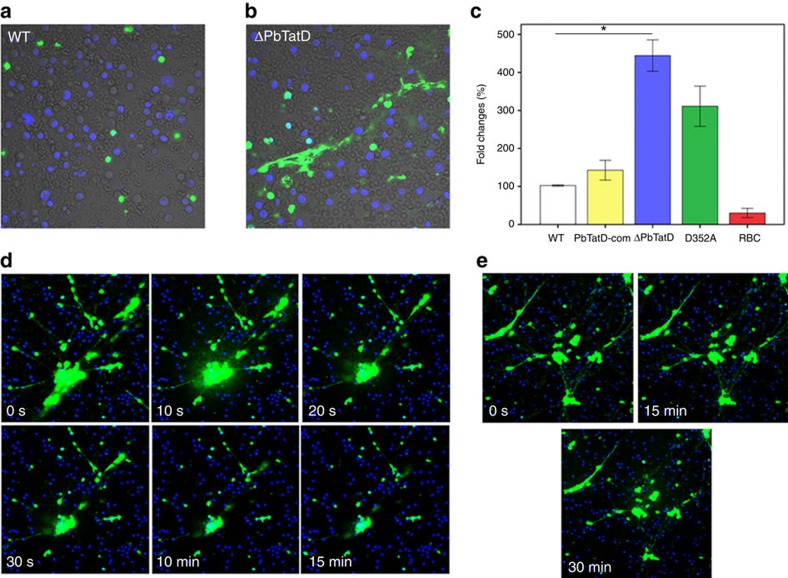
Formation of ETs after incubation of infected erythrocytes with macrophages.Representative images of the extracellular network structures after incubation of J774A.1 macrophages with WT P. berghei (a) and ΔPbTatD (b) infected erythrocytes. The ETs and dead cell nuclei were stained with Sytox green. Scale bar, 20 μm. (c) The relative quantification of ETs released by J774A.1 macrophages stimulated with the WT strain (white bar), ΔPbTatD strain (blue bar), PbTatD-com strain (yellow bar), PbTatD-D352A strain (green bar) or RBCs (red bar) are shown. The WT group was regarded as 100%. The results are the averages of three independent experiments (mean ±s.e.m., *P<0.05 in two-tailed Student's t-test). (d,e) Images of ETs after the addition of rPbTatD-GST or rPbTatD-D352A-GST in the cultivation at various time points. rPbTatD-GST showed DNase activity in a time-dependent manner (d), whereas rPbTatD-D352A-GST did not show any activity (e).